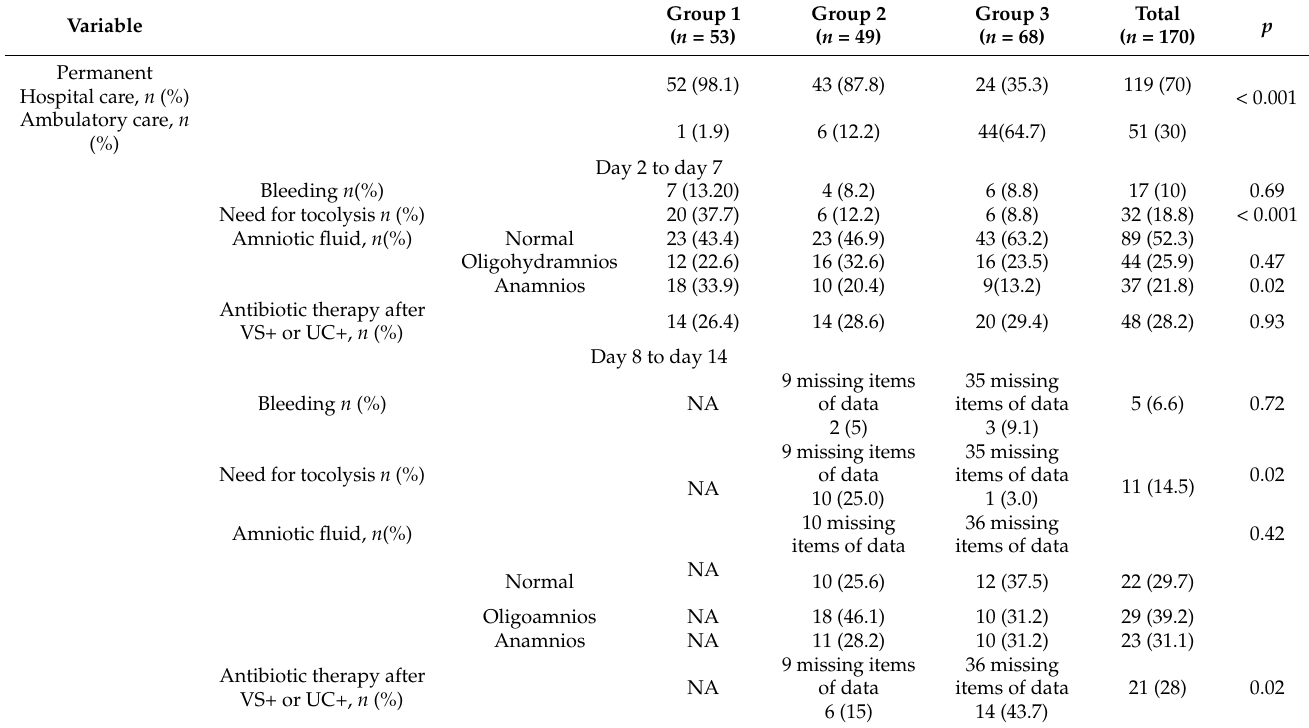
Table 4. Expectant